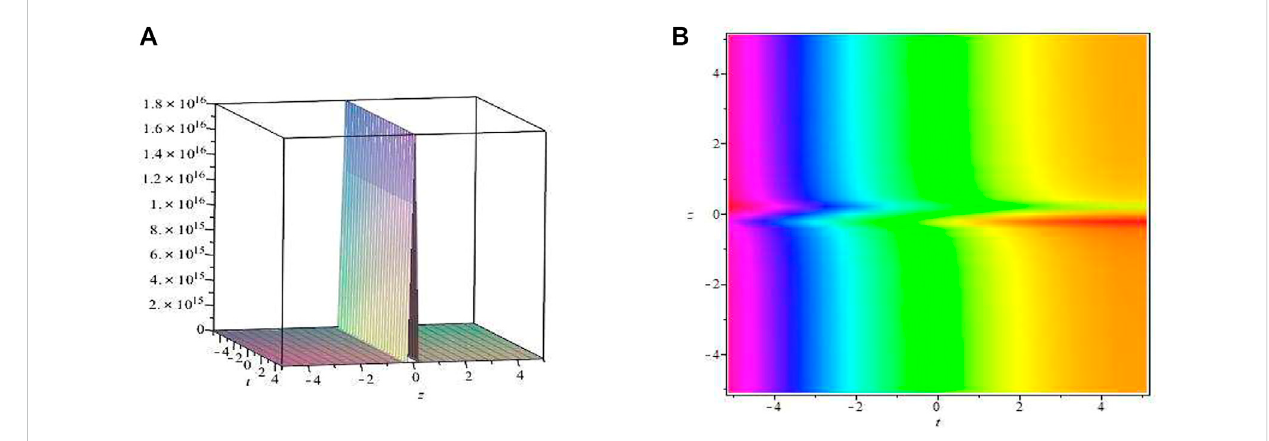
FIGURE 1 Singularity pro fi le of (4.11).